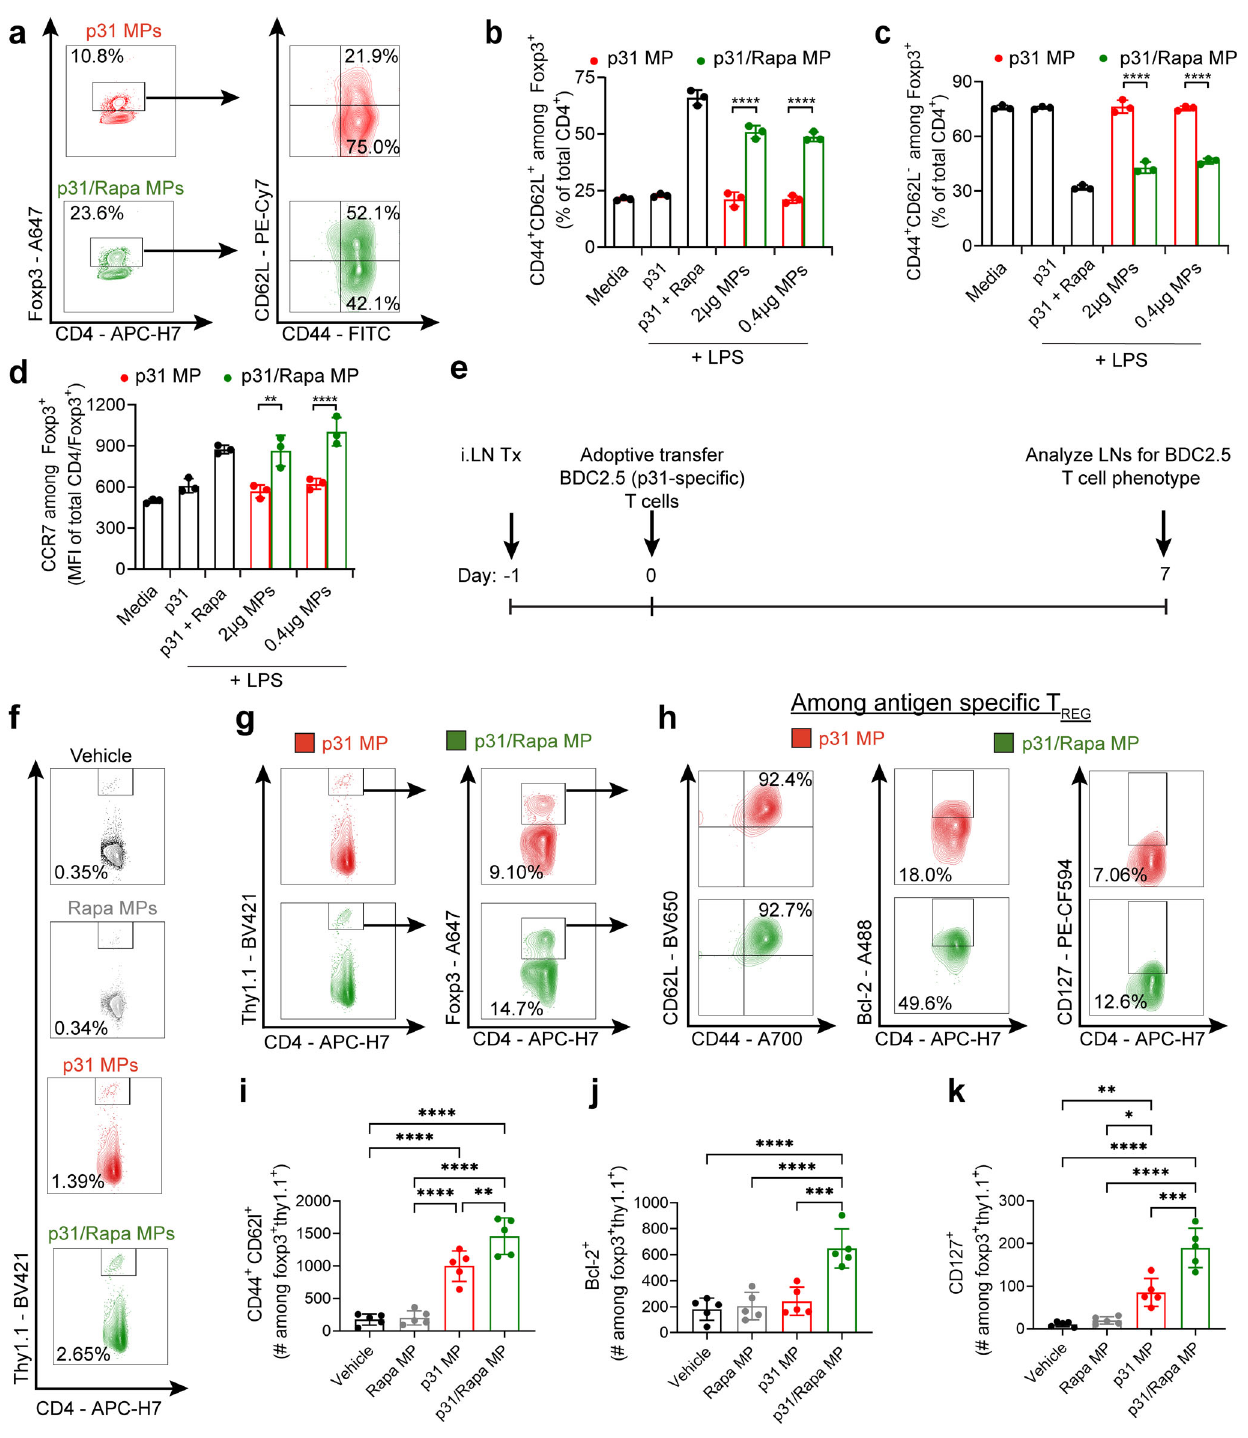
Fig.9|MPtreatmentpromotesexpressionofmemorymarkersamongantigen- speci fi cT REG anddurabletoleranceinT1D. BDC2.5Tcellco-culturesweretreated with p31 MPs or p31/Rapa MPs. a representative gating scheme to quantify co- expression of CD44 and CD62l among BDC2.5T REG . Quanti fi cation of b CD44 + CD62L − and c CD44 + CD62L − frequencies T REG and ( d ) mean fl uorescence intensityofCCR7amongBDC2.5T REG . N =3foreachsample.One-wayANOVAwith Tukey ’ sposthoctestwasusedtocompareallgroups.Comparisonsforp31MPand p31/Rapa MPsatmatched doses are indicated in plots. e Schematicrepresentation of BDC2.5 T cell adoptive transfer experiment in panels f – k . N =5 for each